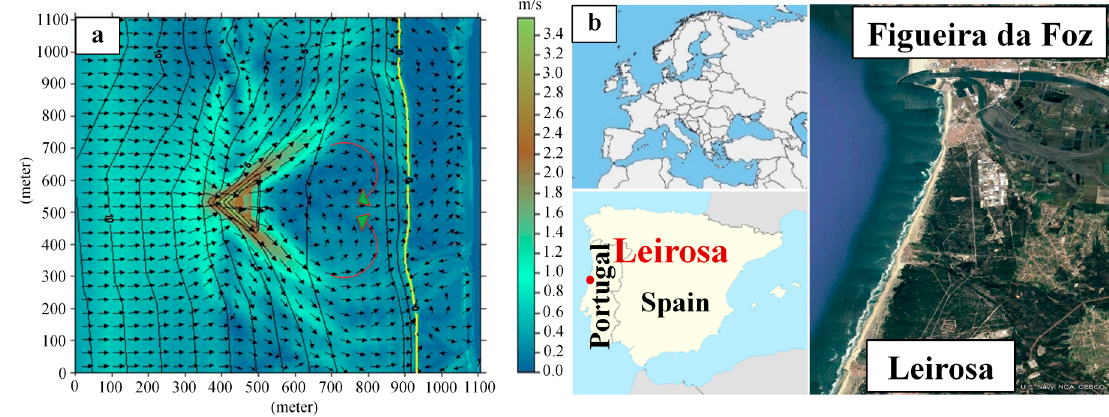
Figure 1. ( a )Velocitypatternaroundthereefstructure(adaptedfrom[25]); ( b Figure 1. ( a ) Velocity pattern around the reef structure (adapted from [25]); ( b ) Leirosa location in Portugal.